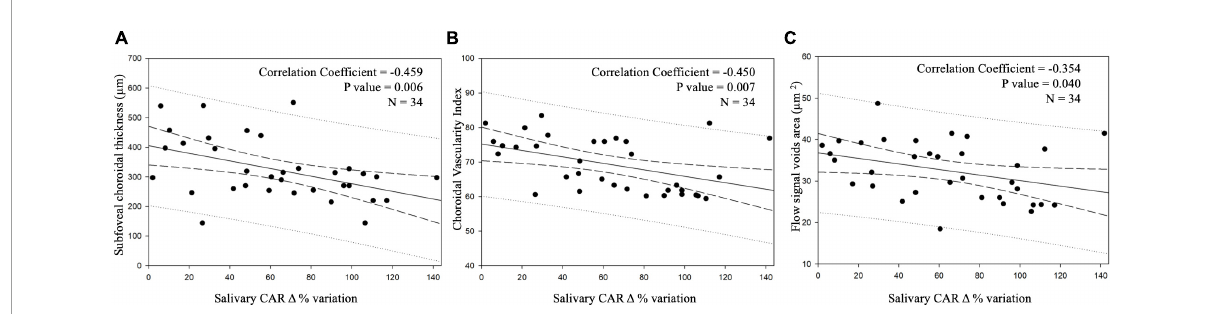
FIGURE3 Scatterplots showing relationships between salivary cortisol awake response (CAR) delta percentage ( (cid:49) %) variation and the selected biomarkers of central serous chorioretinopathy (CSC) imaging in the study population: subfoveal choroidal thickness (FCT) (A) , choroidal vascularity index (CVI) (B) , and total flow signal void areas (C) in the study population. Continuous lines represent the best-fit linear regression; long dashed lines represent confidence bands; dotted lines represent prediction